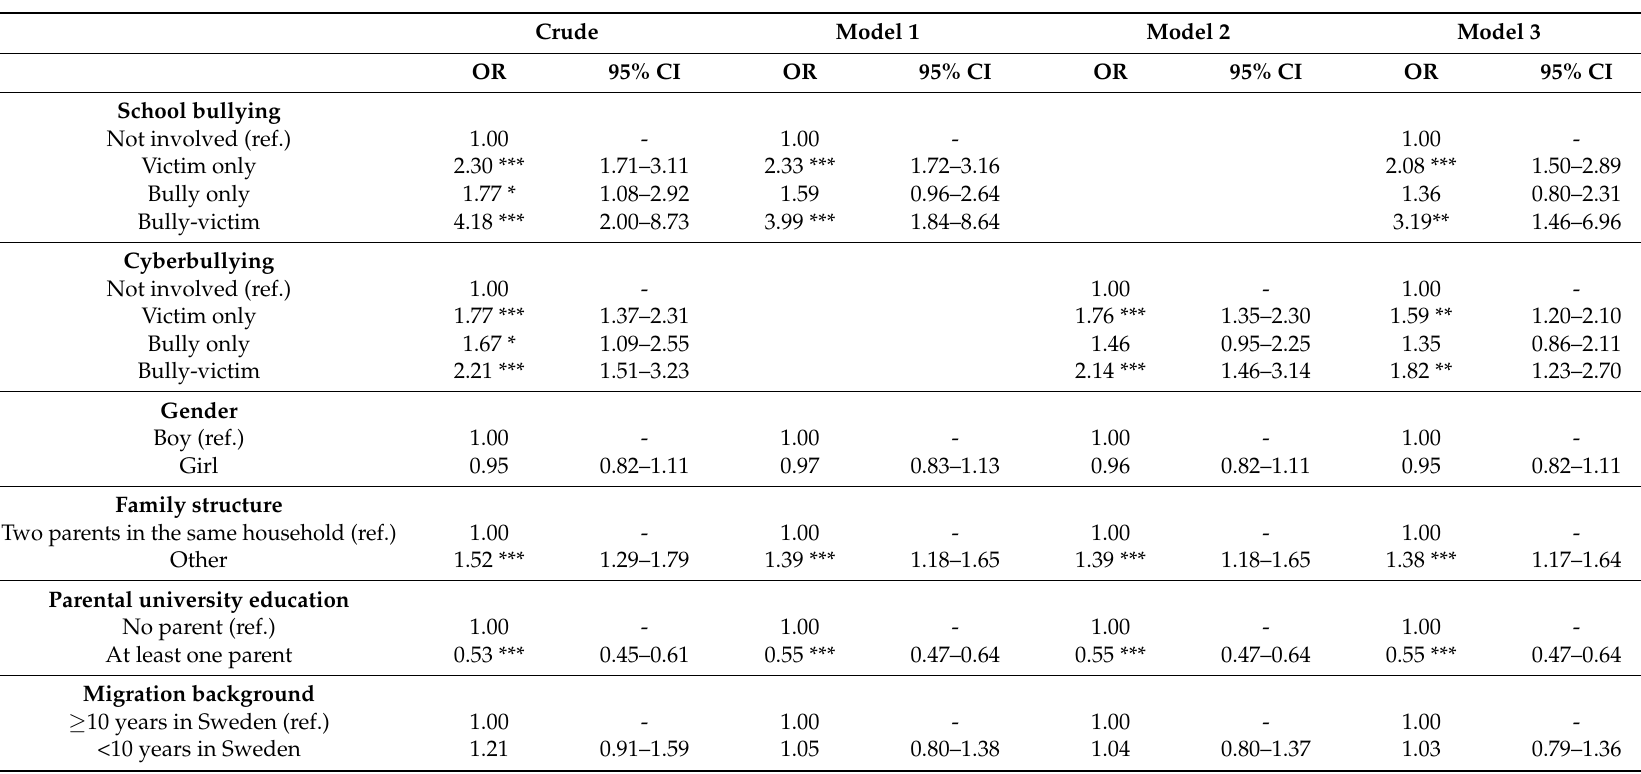
Table 4. Pessimistic future orientation by school bullying and cyberbullying status (reference category=not pessimistic future orientation). Odds ratios from binary logistic regressions. n =